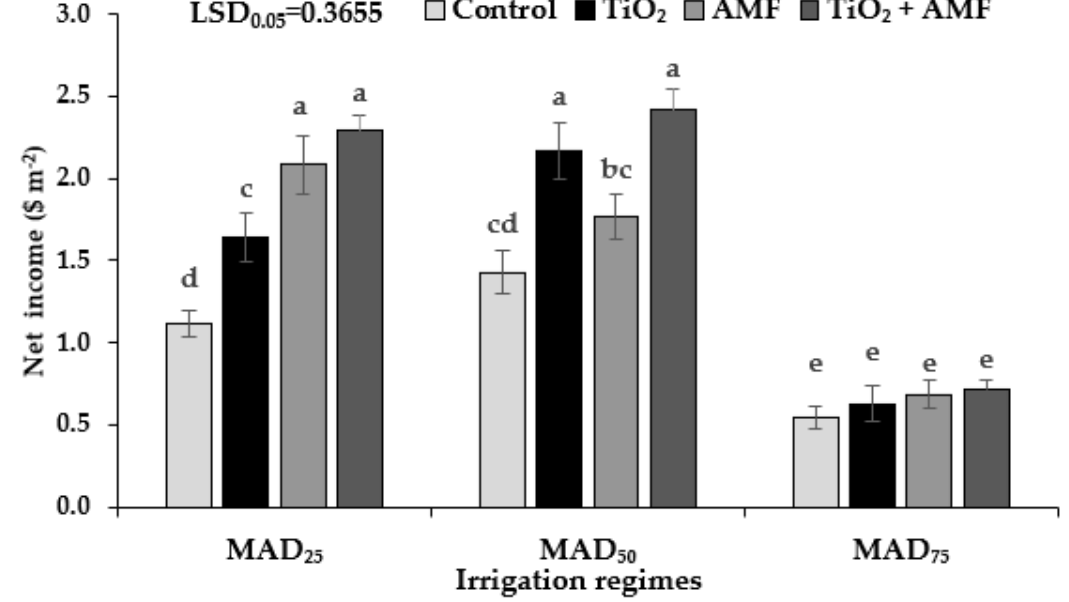
Figure 5. The net income of sage in different irrigation regimes and fertilizer sources. MAD 25 , MAD 50 , and MAD 75 indicating non ‐ stressed, moderate, and severe drought stress, respectively. AMF: arbuscular mycorrhizal fungi; TiO 2 : titanium dioxide nanoparticle. Different letters indicate significant differences at the 5% level according to LSD test.